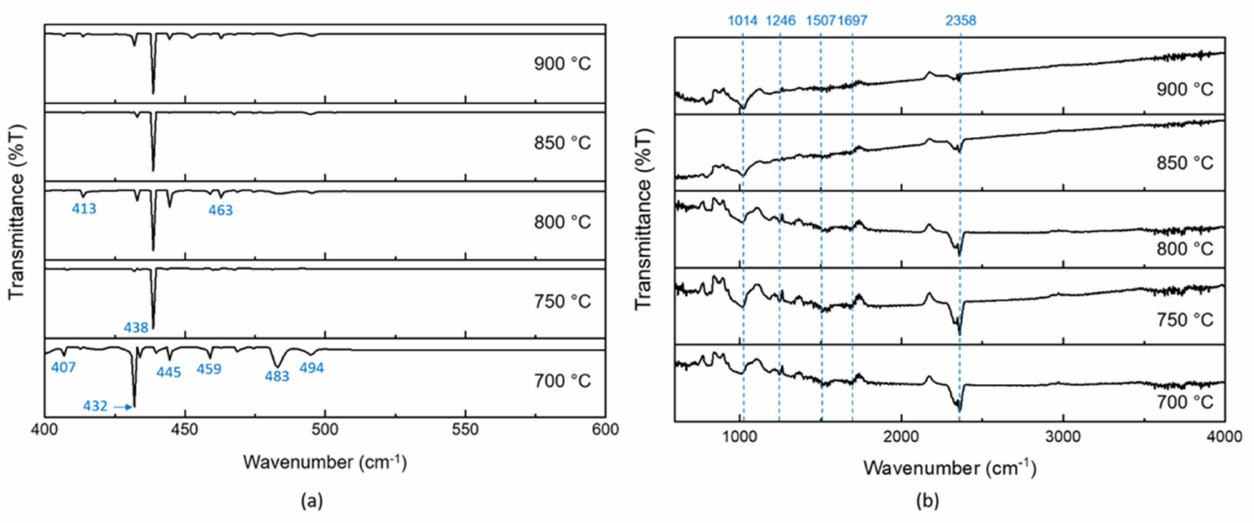
Figure 11. FTIR spectra of samples synthesized at various sample reaction temperatures of 700, 750, 800, 850 and 900 ◦ C. ( a ) The wavenumber ranged from 400 to 600 cm − 1 and ( b ) the wavenumber from 600 to 4000 cm − 1